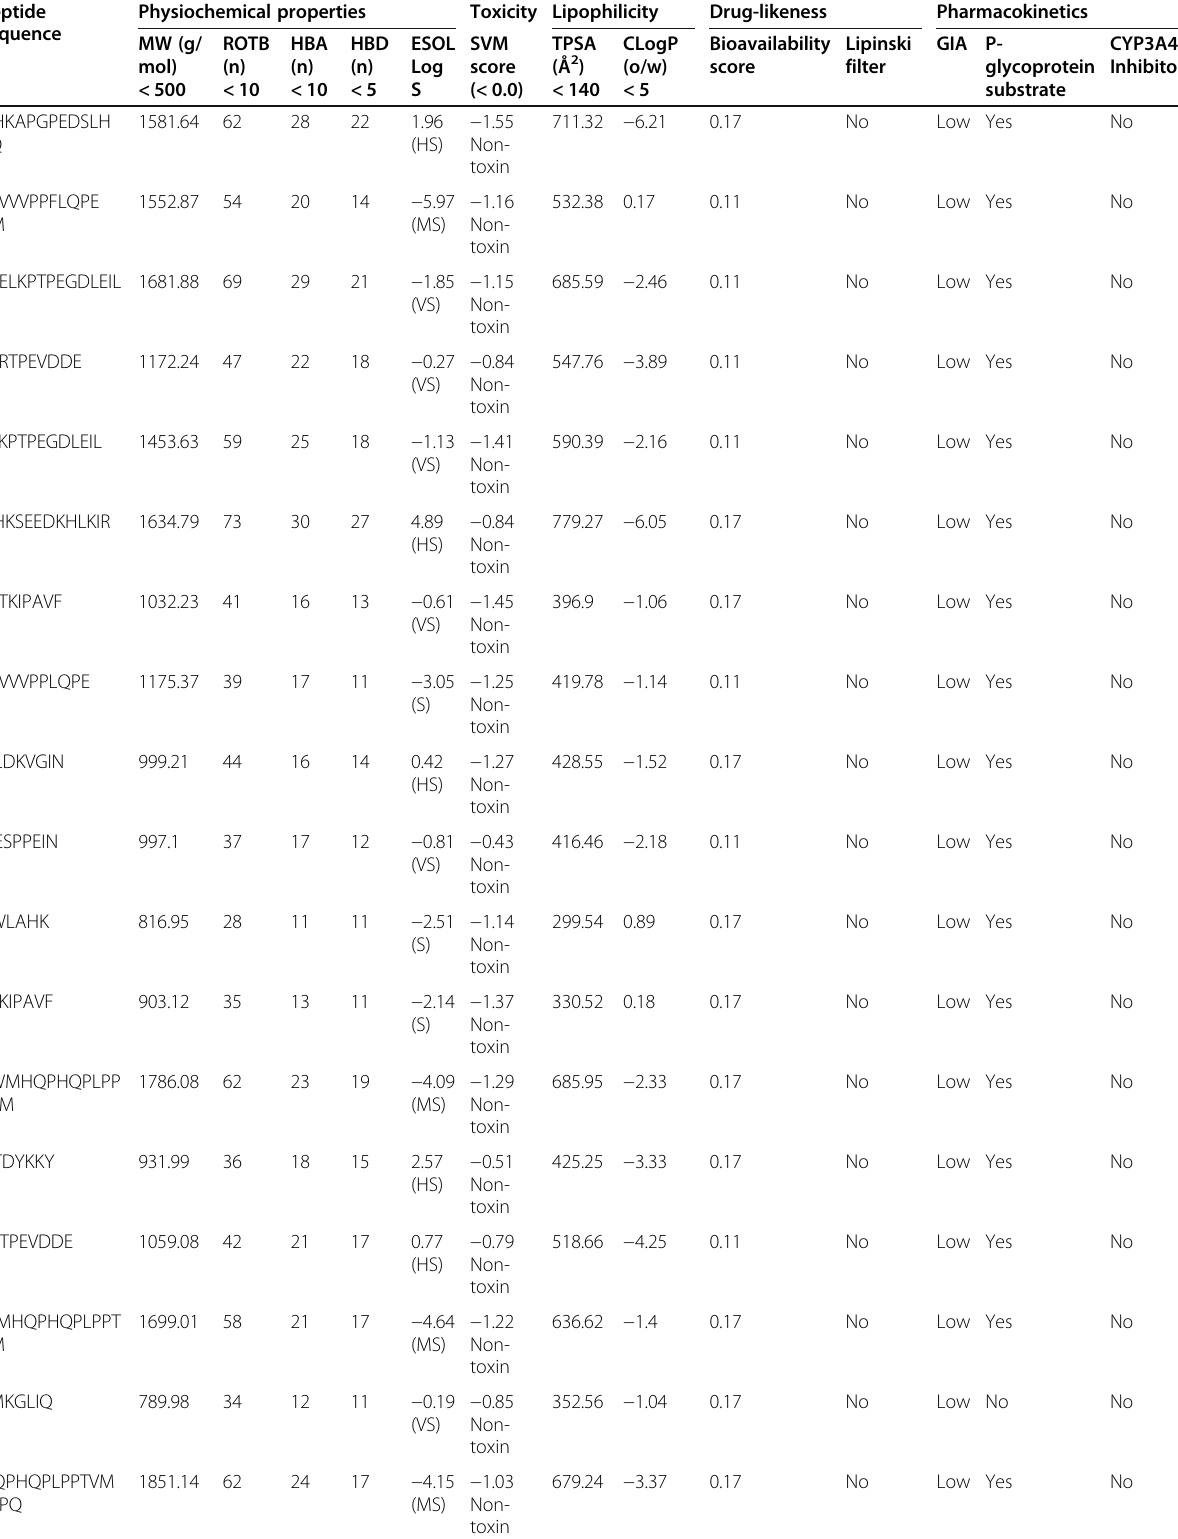
Table 2 In silico absorption, distribution, metabolism, excretion and toxicity (ADME/Tox) profile of whey protein-derived zinc- binding peptides Peptide